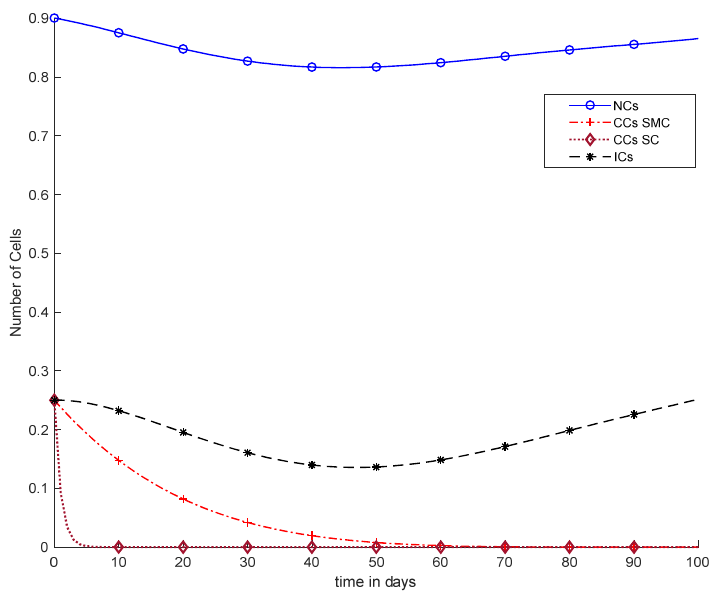
Figure 12. With chemotherapy at a continuous dose and SMC on CCs (‘+’ line) with effect on all equations and SC on CCs (‘ − ’ line).